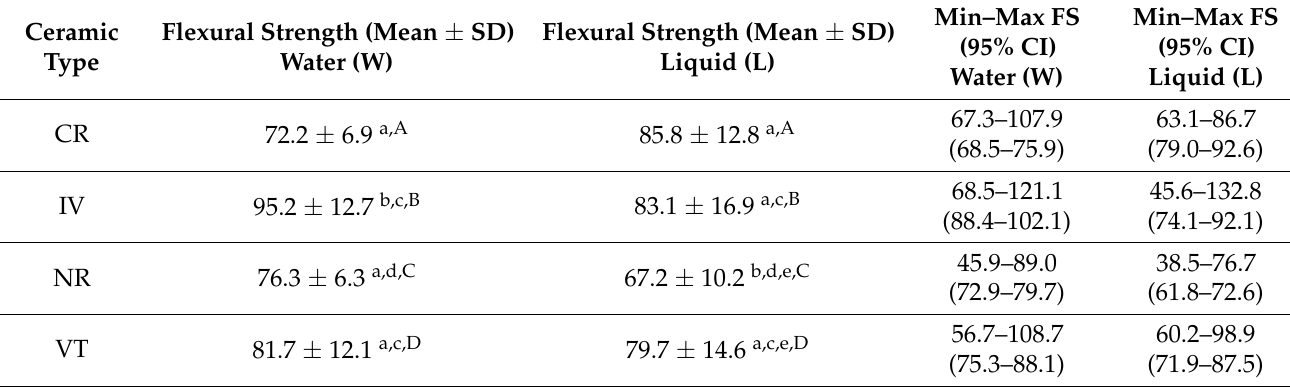
Table 3. The mean flexural values (MPa ± standard deviations) of IV, NR, VT, and CR, and their related modeling liquids. 95% confidence interval of mean values of IV, NR, VT, and CR, and their related modeling liquids. The same superscript lowercase letters in the same column indicate no significant differences and uppercase letters based on the experimental group ( p <